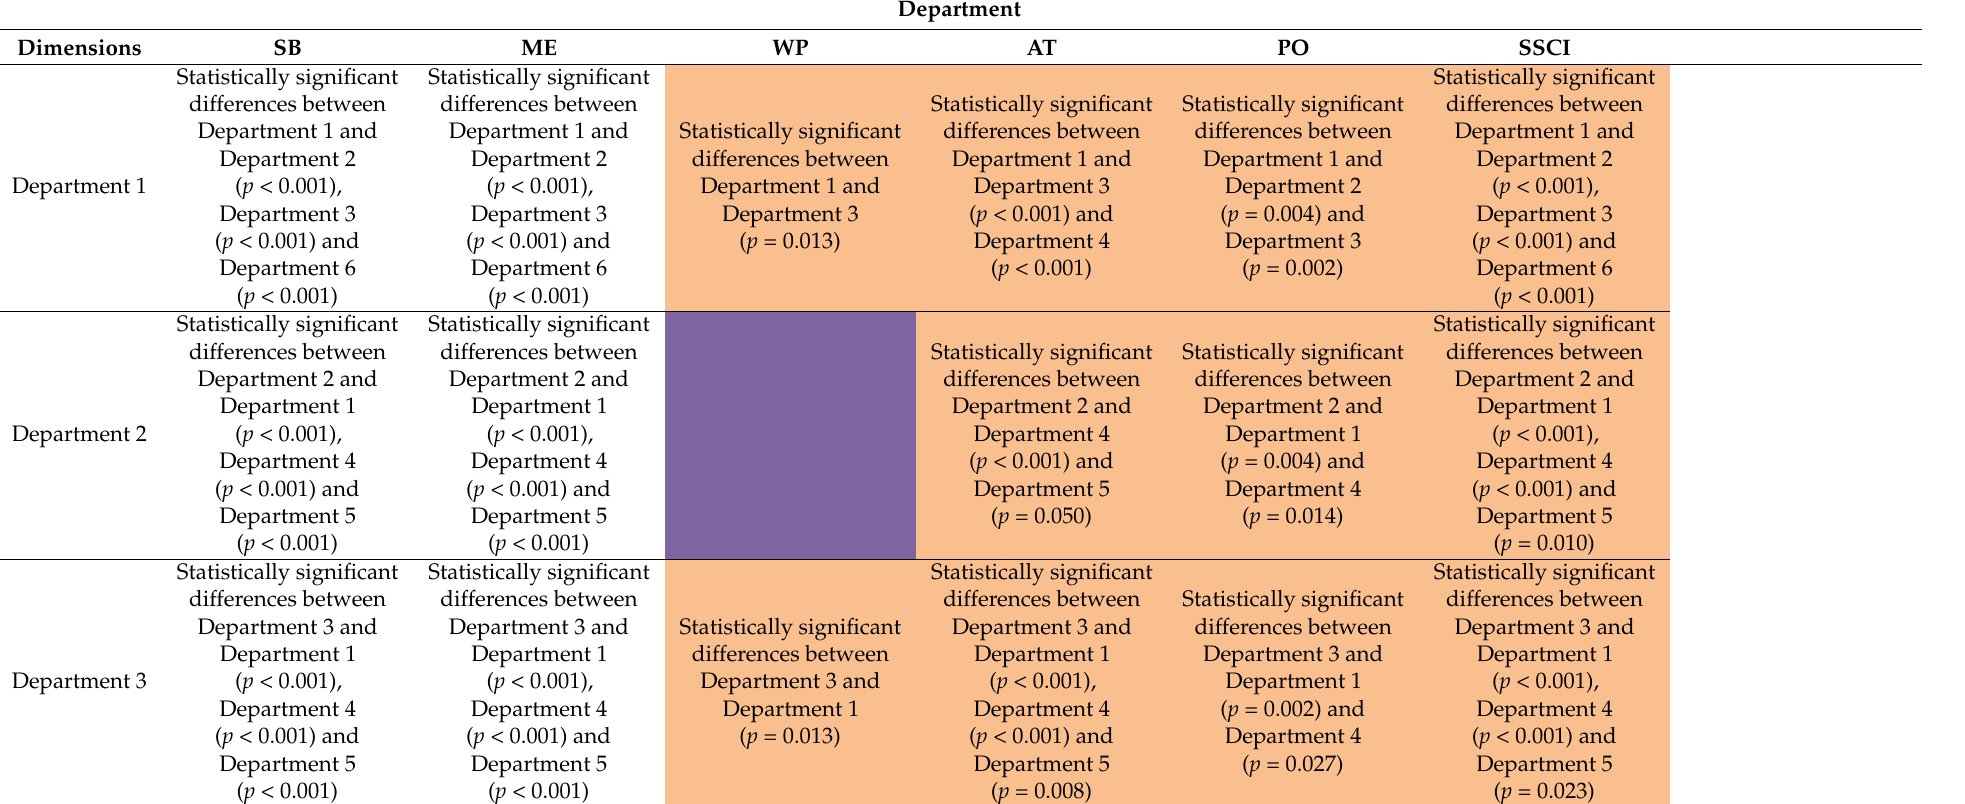
Table A2. The results of post hoc